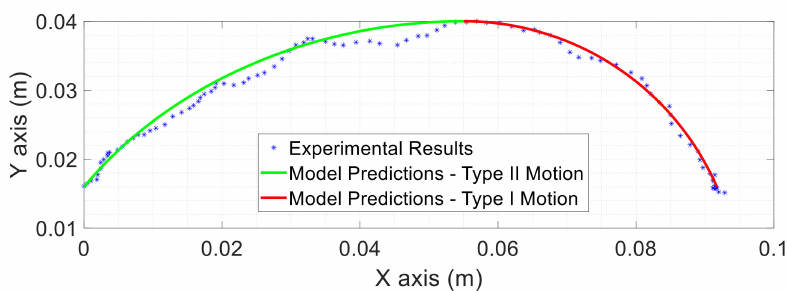
Figure 14. Motion Trajectory Experimental Results obtained with a system of r = 0.02 m throughout one complete revolution compared to the Model Predictions.